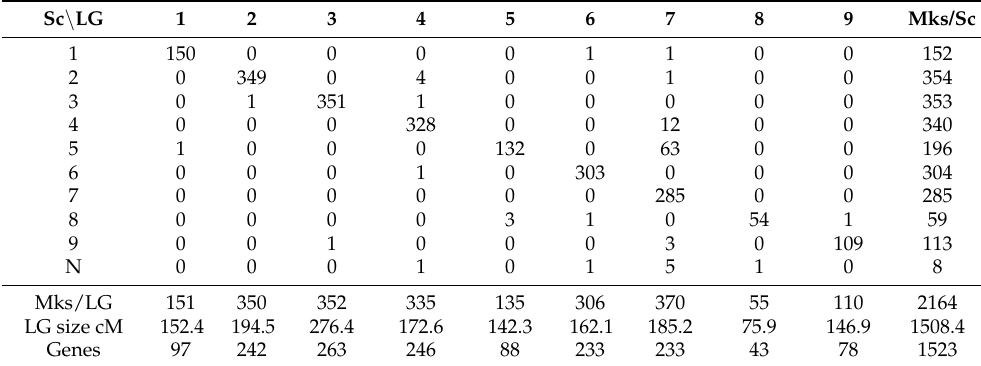
Table 1. Summary of ‘Fortune’ mandarin mapping data.